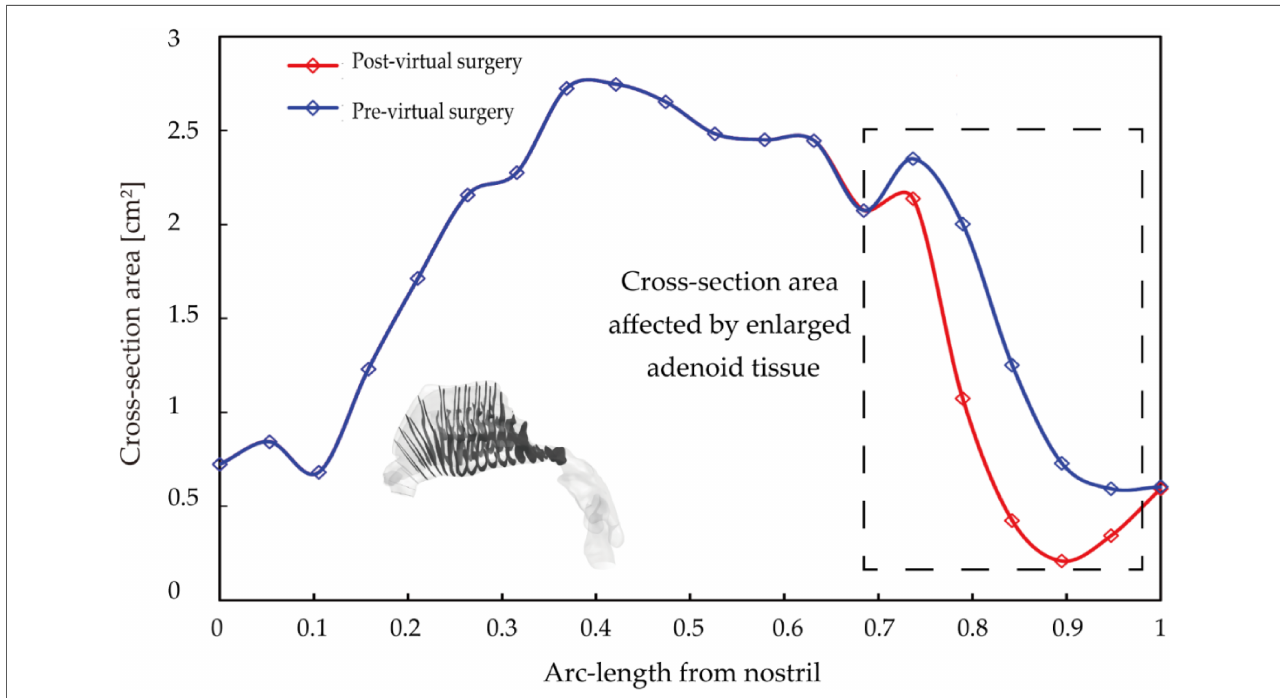
FIGURE 6 Cross-section area comparison pre- and post-virtual surgery as a function of normalized arc-length away from nostril, where adenoid hypertrophy region highlighted by the rectangle wireframe.